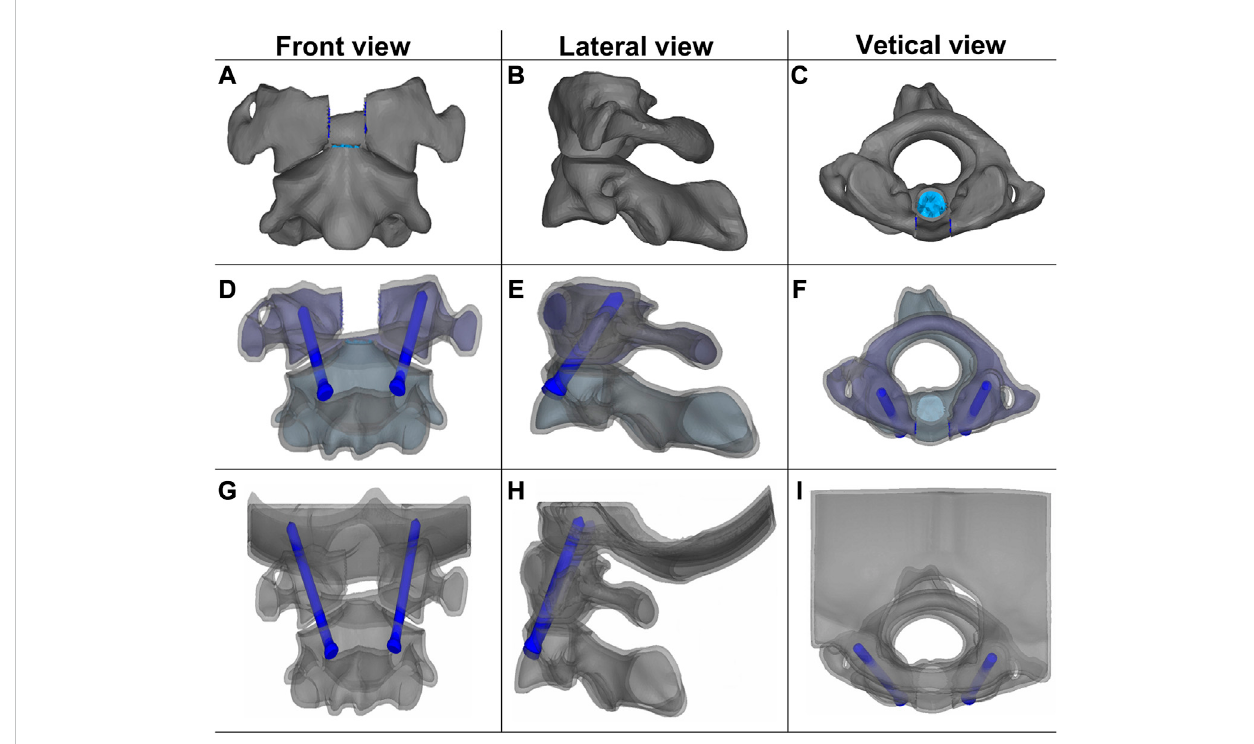
FIGURE 2 Front, lateral, and vertical views of the three surgical fi nite element models: Odontoidectomy (A – C) , AAF (D – F) , and AAOF (G – I) models. AAOF, anterior axis-atlanto-occipital transarticular fi xation; AAF, anterior atlantoaxial transarticular fi xation. (A) was reproduced from the ref. (Xie et al., 2021), Copyright (2021), with permission from